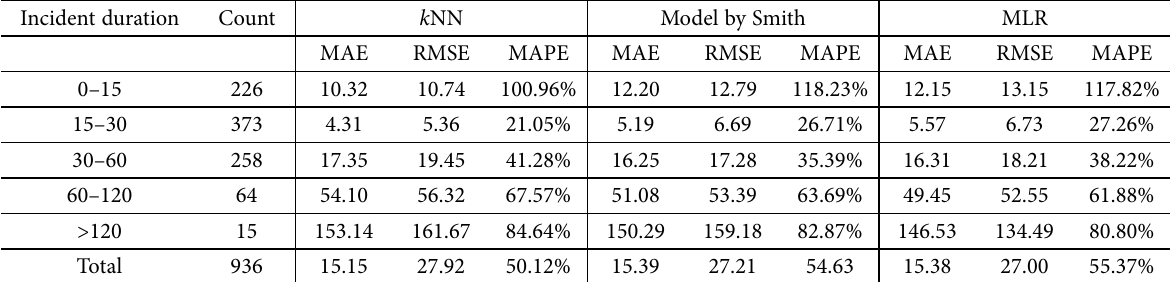
Table 6. Prediction results for incidents with different duration ranges